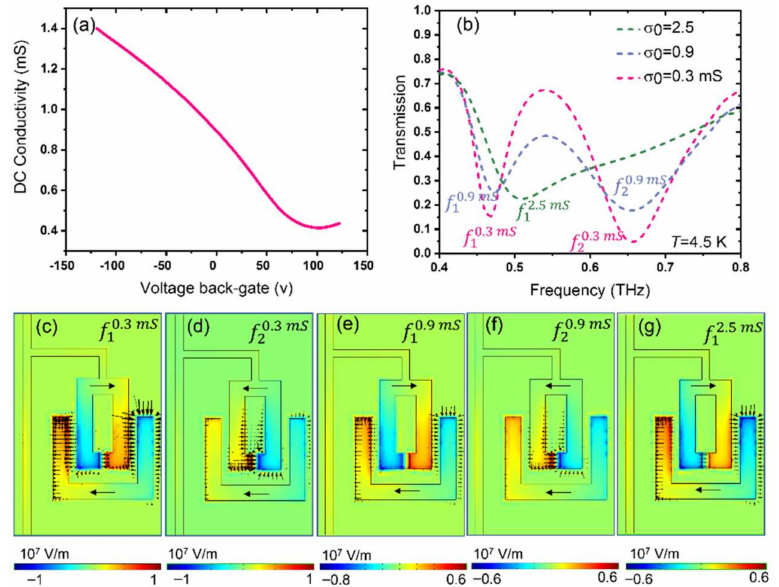
Figure 3. ( a ) The measured conductivity of graphene as a function of back-gate voltage; ( b ) Simulated THz transmission of the active/electrically tunable photonic integrated circuit with hybrid graphene– superconducting Nb SRR arrays for three different graphene conductivity, σ 0 = 0.3 mS (dashed red), σ 0 = 0.9 mS (dashed purple), and σ 0 = 2.5 mS (dashed green). ( c – g ) The z -component of the electric field E z and surface current distribution at the relevant resonance frequencies shown in ( b